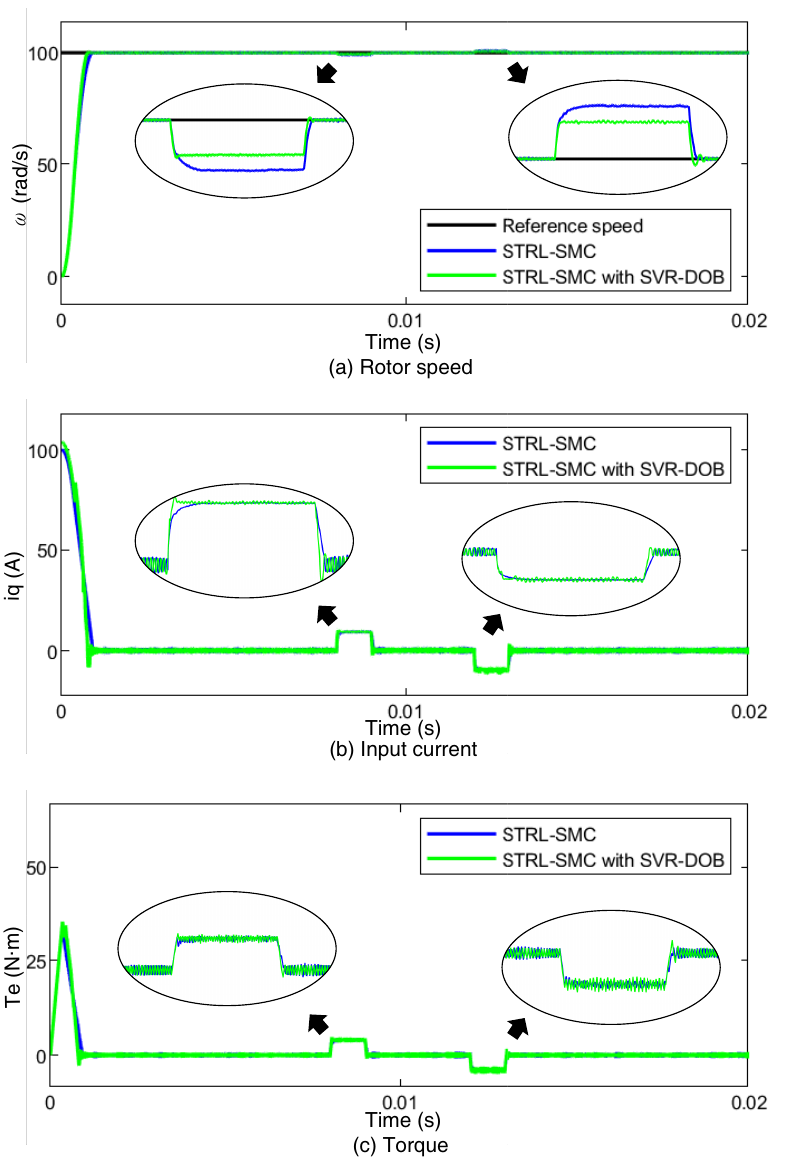
Figure 5. Comparison between STRL-SMC and STRL-SMC with